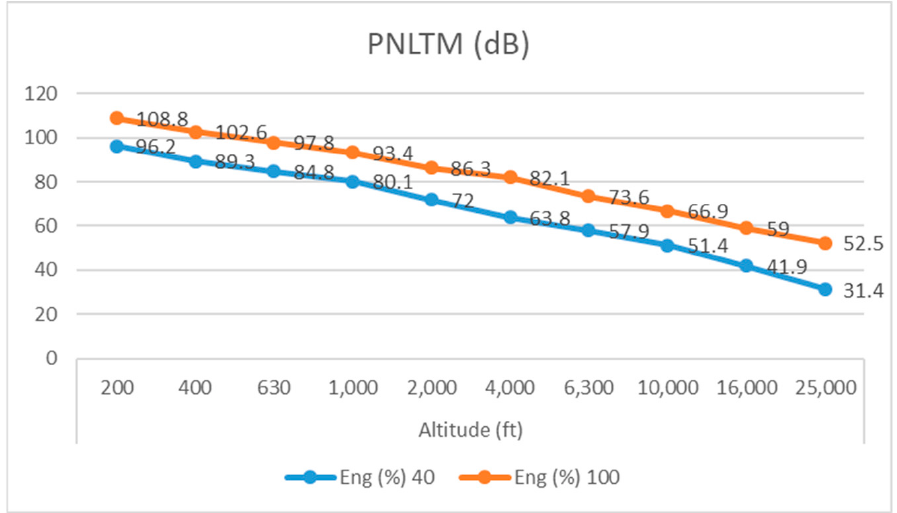
Figure 37. NPD curves, in terms of PNLTM, for the DEP configuration.